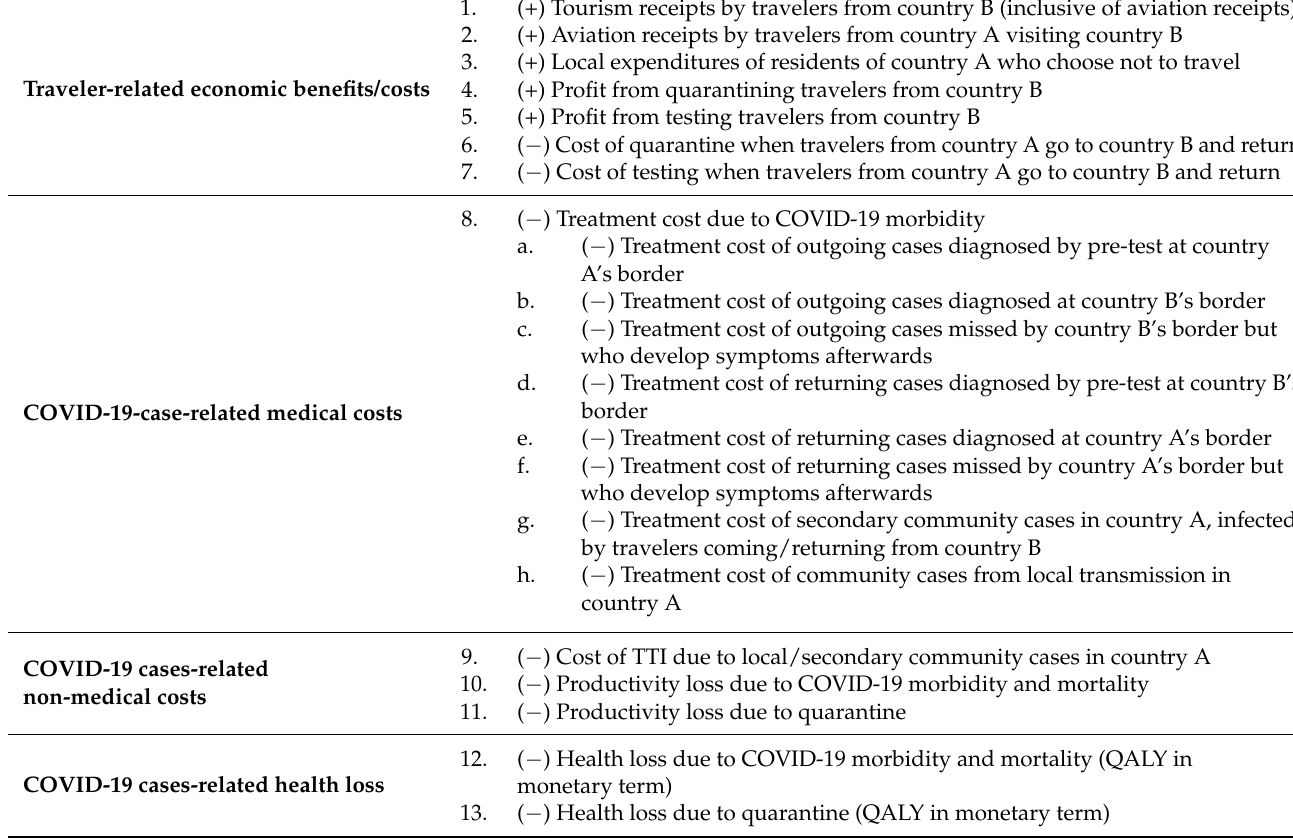
Table 2. Cost/benefit components from country A’s